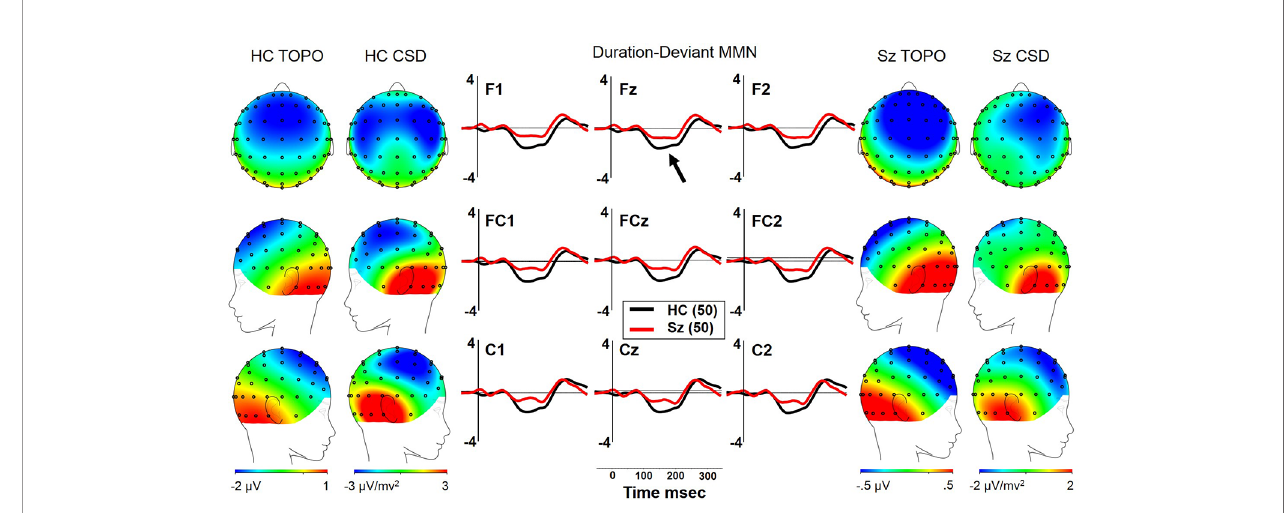
FIGURE 2 | dMMN in long-term schizophrenia. HC, Healthy Control subjects; Sz, Long-term Schizophrenia subjects; Topo, Voltage topography; CSD, Current Source Density